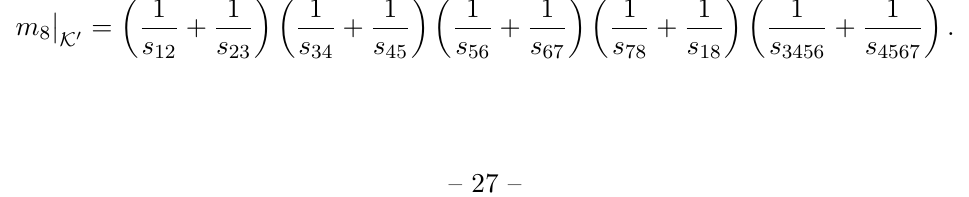
Figure 9 . Smoothly splitting a current: intersecting the split kinematics subspaces, K K (1 , 5 , 7)